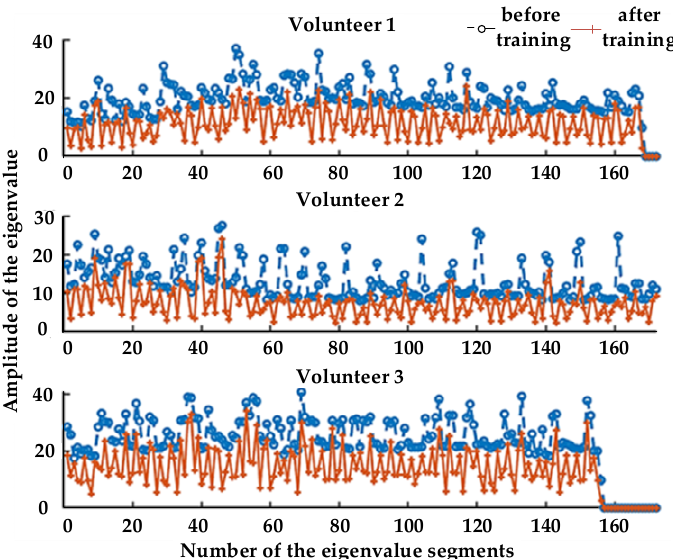
Figure 18. Changes in MAV.